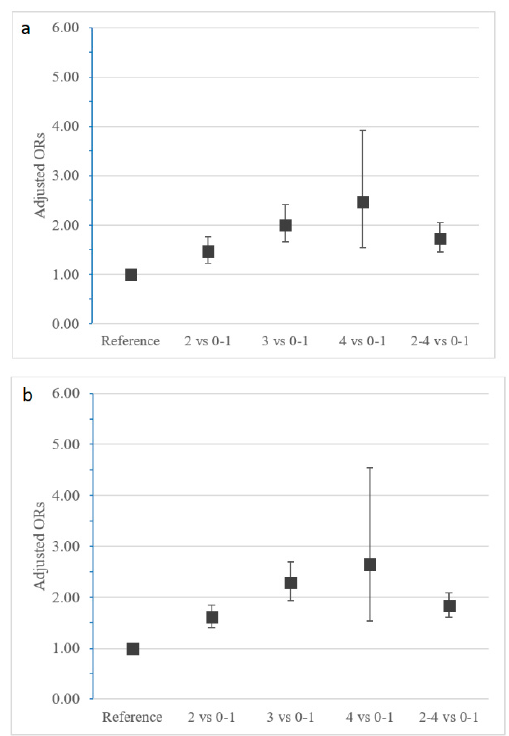
Figure 1. Associations of ( a ) healthy ageing and ( b ) survival with the number of healthy behaviours. Notes: ORs: Odds Ratios (pooled effects of the fixed-effects meta-analysis); models are adjusted for sex, age and education level and for all behaviours at baseline. Associations are given per individual number of healthy behaviours (two, three, four) and for two-four compared to no or one healthy behaviour (reference category). Error bars indicate 95% confidence intervals.